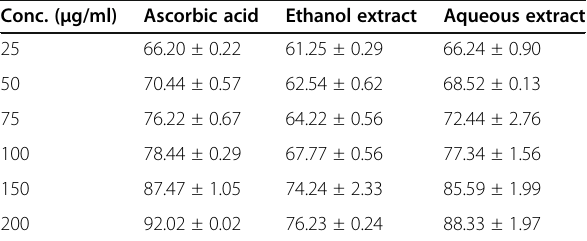
Numbers indicate means ± standard deviation of